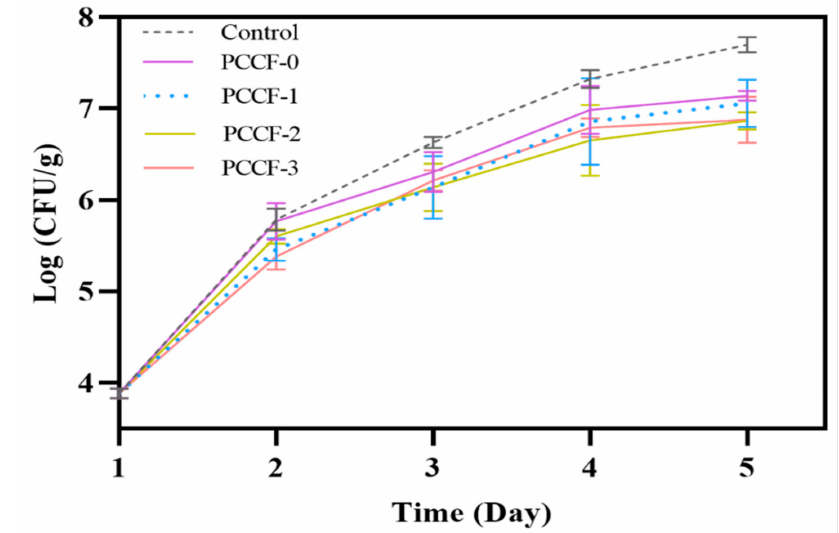
Figure 7. The antiseptic activity of PCCF in food